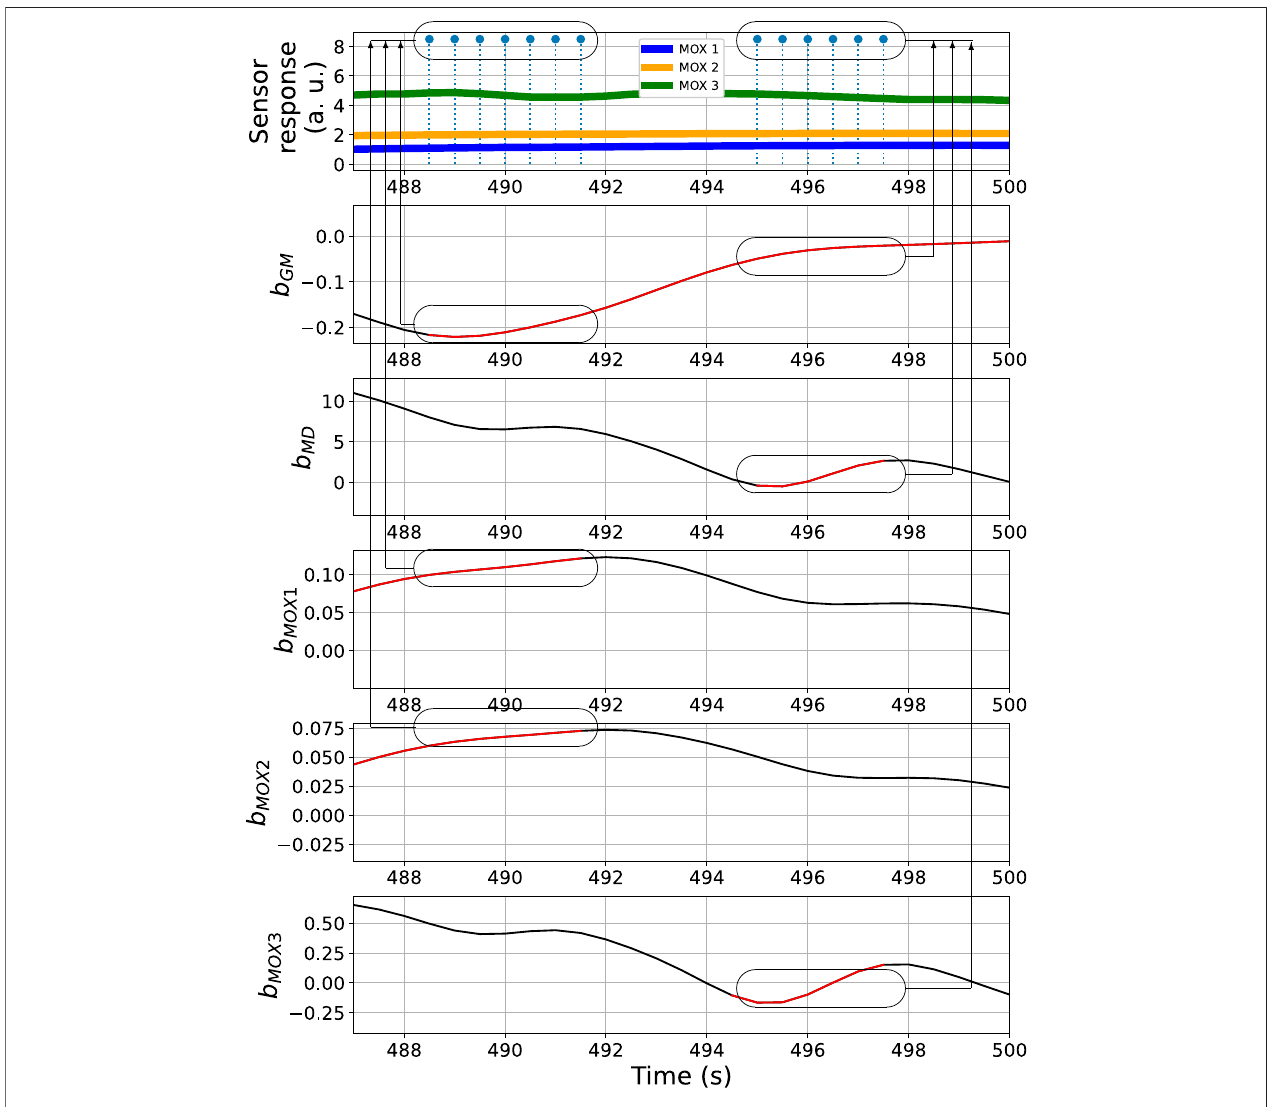
FIGURE9| Boutanalysisandpredictionresultoftheperiodfrom487to500 softhetimeseriesshownin Figure7 .Theovalsinthetopsubplotindicatetheoverall bout detection results, while the ovals in the other subplots correspond to the detected bouts contributed from each signal source.